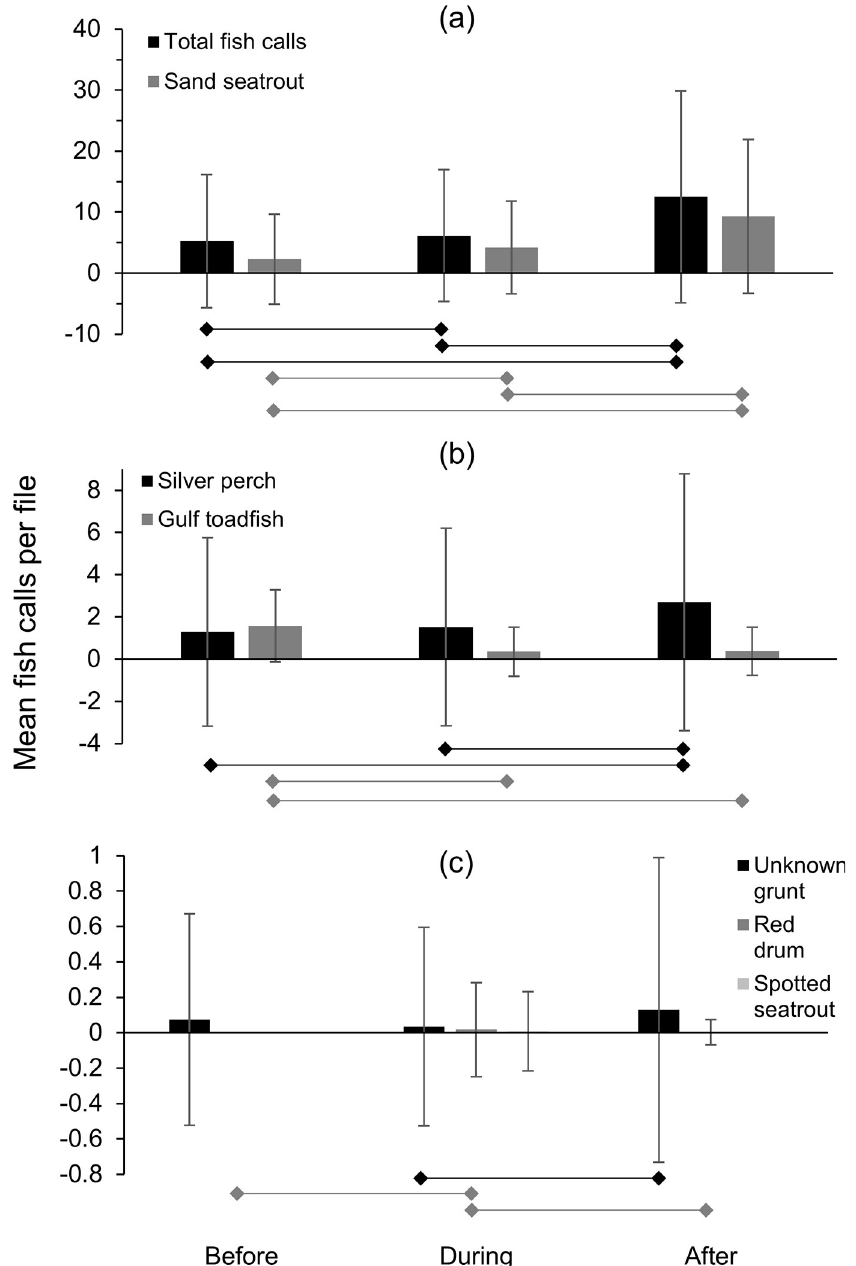
Fig 10. Mean fish detections per file at station Gulf 1 during Tropical Storm Debby. Mean number of fish calls detected per file per acoustic file before, during and after the passage of Tropical Storm Debby at station Gulf 1 (offshore); (a) total fish calls (all species) and sand seatrout calls (b) silver perch and gulf toadfish calls, (c) unknown grunt, red drum and spotted seatrout calls. Bars beneath plots indicate significant relationships in post-hoc tests (p <